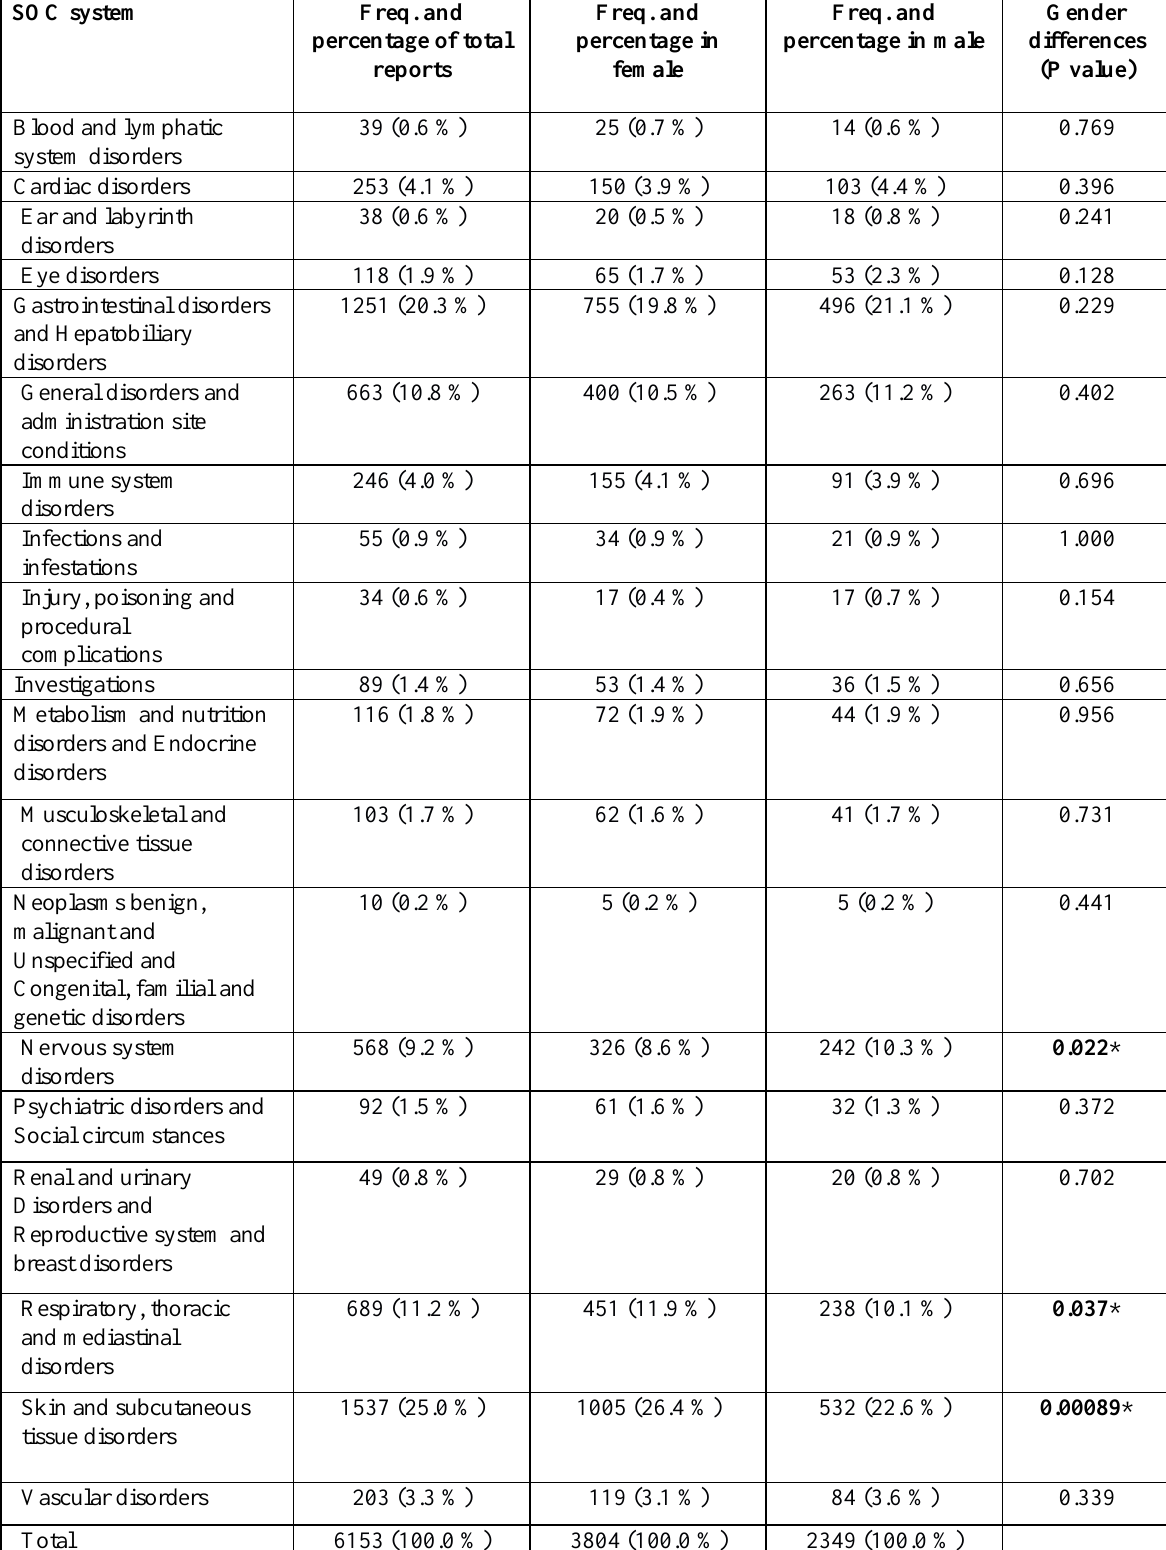
Table 2. Distribution of ADR according to the SOC system in both genders. SOC